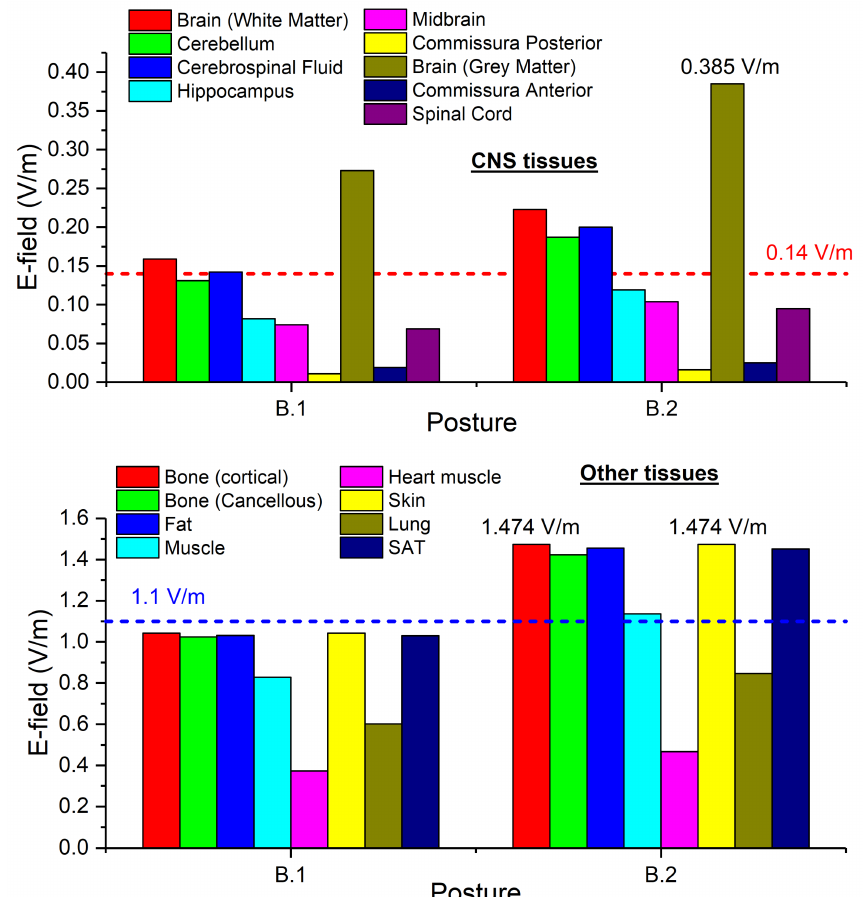
Figure 14. Exposure scenario B: on the upper diagram, maximum values of E-field (V / m) for the CNS tissues, on the bottom diagram, maximum values of E-field (V / m) for a selection of other